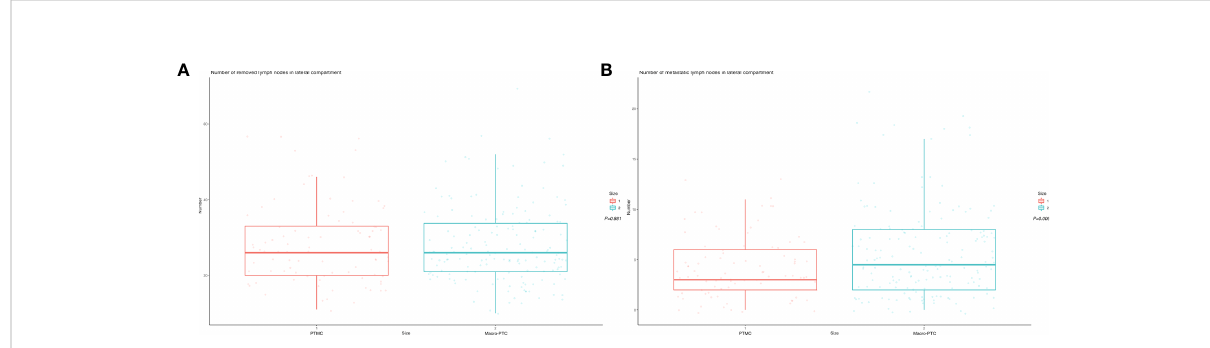
FIGURE 2 Boxplot of number of lymph nodes. (A) Number of removed lymph nodes in lateral compartment: PTMC group vs. macro-PTC group: 28.1 ± 10.7 vs. 27.9 ± 10.2, p = 0.881; (B) number of metastatic lymph nodes in lateral compartment: PTMC group vs. macro-PTC group: 4.3 ± 3.1 vs. 5.6 ± 4.5, p =